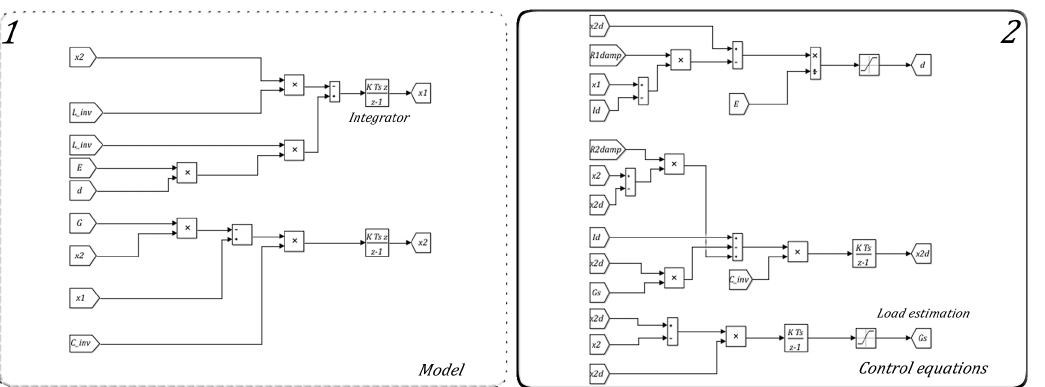
Figure 12. Boost model and IDA-PBC control equations in block diagrams.